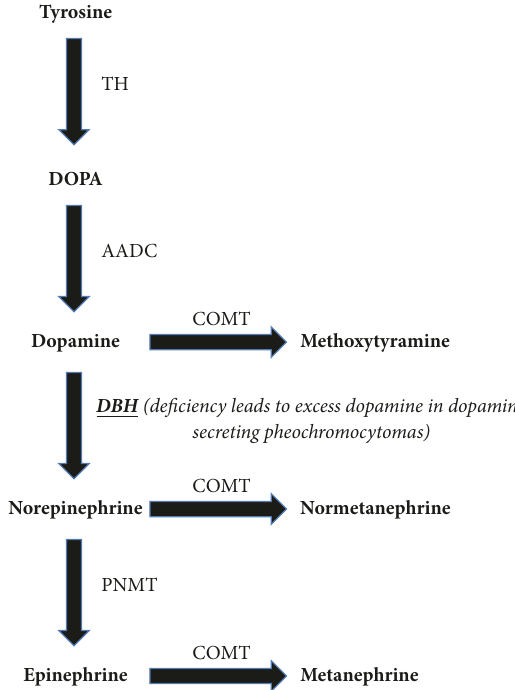
Figure 1: Catecholamine synthesis pathway. TH: tyrosine hydroxy- lase; AADC: aromatic amino acid decarboxylase; DBH: dopamine B-hydroxylase; PNMT: phenylethanolamine- N -methyltransferase; COMT: catechol- O -methyltransferase. Deficiency in dopamine B- hydroxylase leads to elevated dopamine levels in dopamine secreting pheochromocytomas